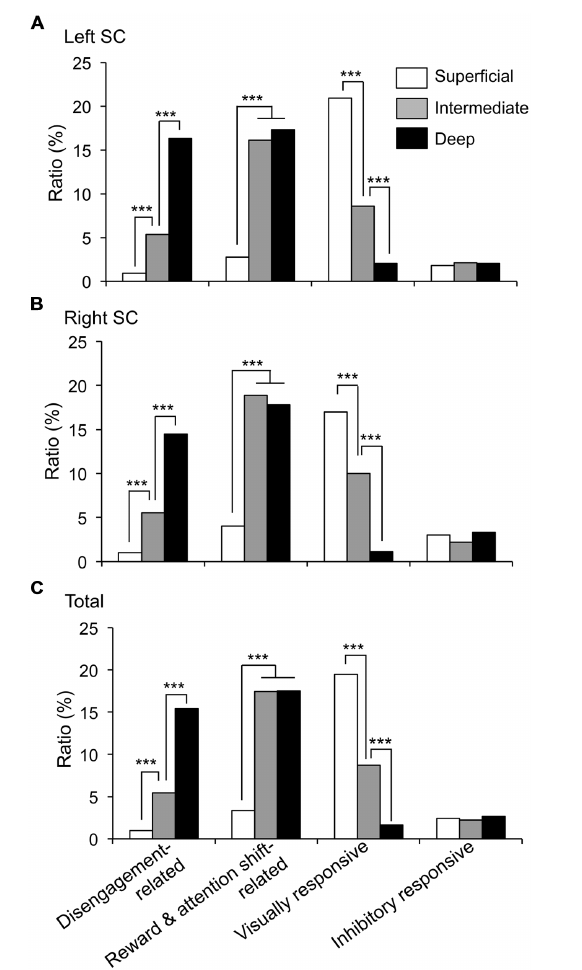
FIGURE 10 | Ratios of each neuronal type in the superficial, intermediate, and deep layers of the SC. (A–C) Ratios of the neurons in each layer in the left SC (A) , right SC (B) and both sides of the SC (C) . ***significant difference (Chi-squared test, P <